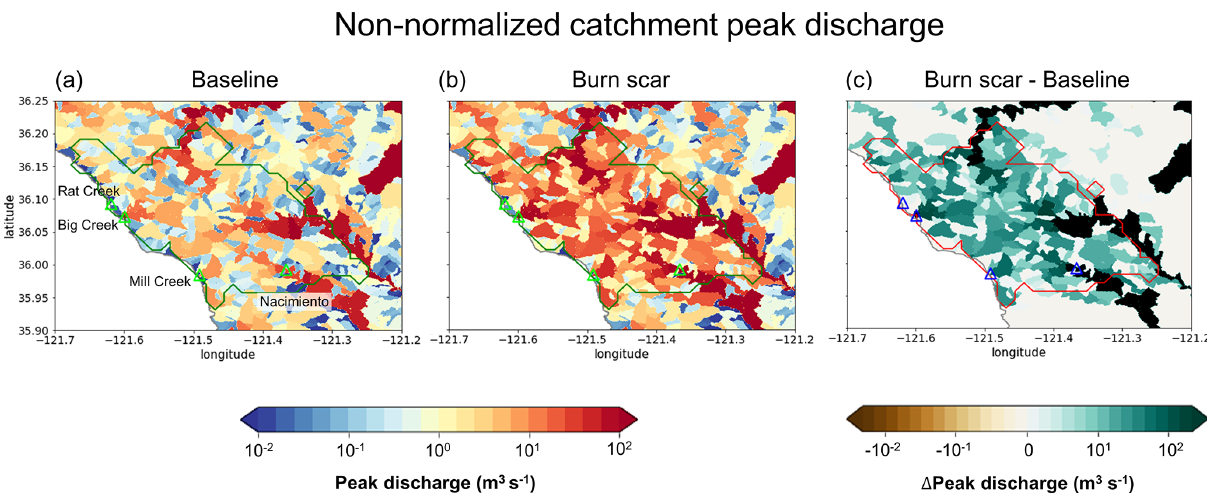
Figure B8. Non-normalized peak discharge at catchment level in the (a) baseline simulation and (b) burn scar simulation and (c) the difference between the burn scar and baseline simulations (m 3 s − 1 ; shading). For each catchment, the peak discharge is the maximum discharge rate at the catchment outlet from 27 January 00:00 to 28 January 12:00. Triangles stand for debris flow deposition locations and are annotated in (a)